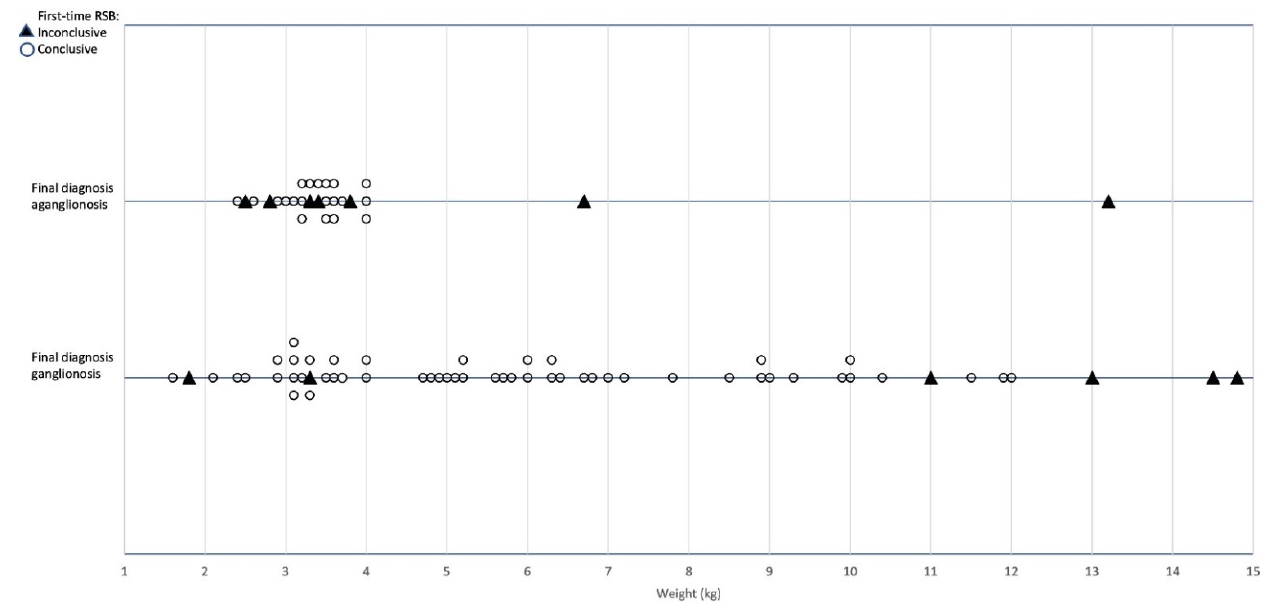
Figure 4. Descriptive overview of all 84 rectal suction biopsies with regard to weight, conclusive or inconclusive result on first biopsy, and final diagnosis of aganglionosis/ganglionosis.